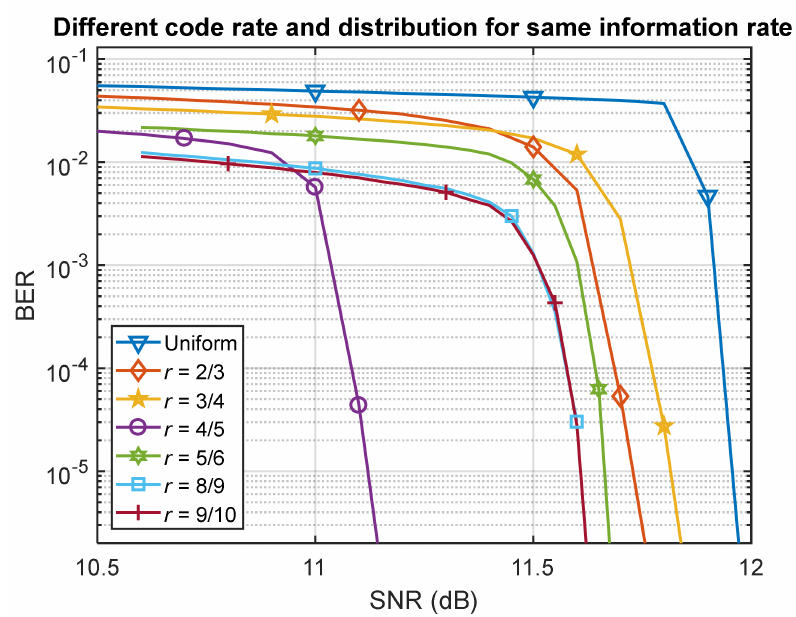
Figure 4. Bit error ratio (BER) performance for di ff erent LDPC code rates ( r ). SNR: Signal-to-noise